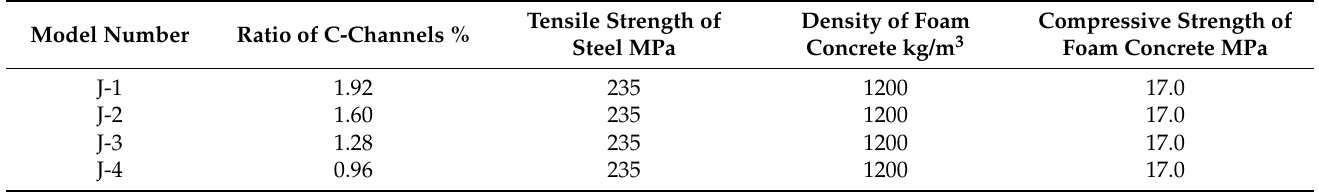
Table 4. Mechanical properties of models J-1to J-4.